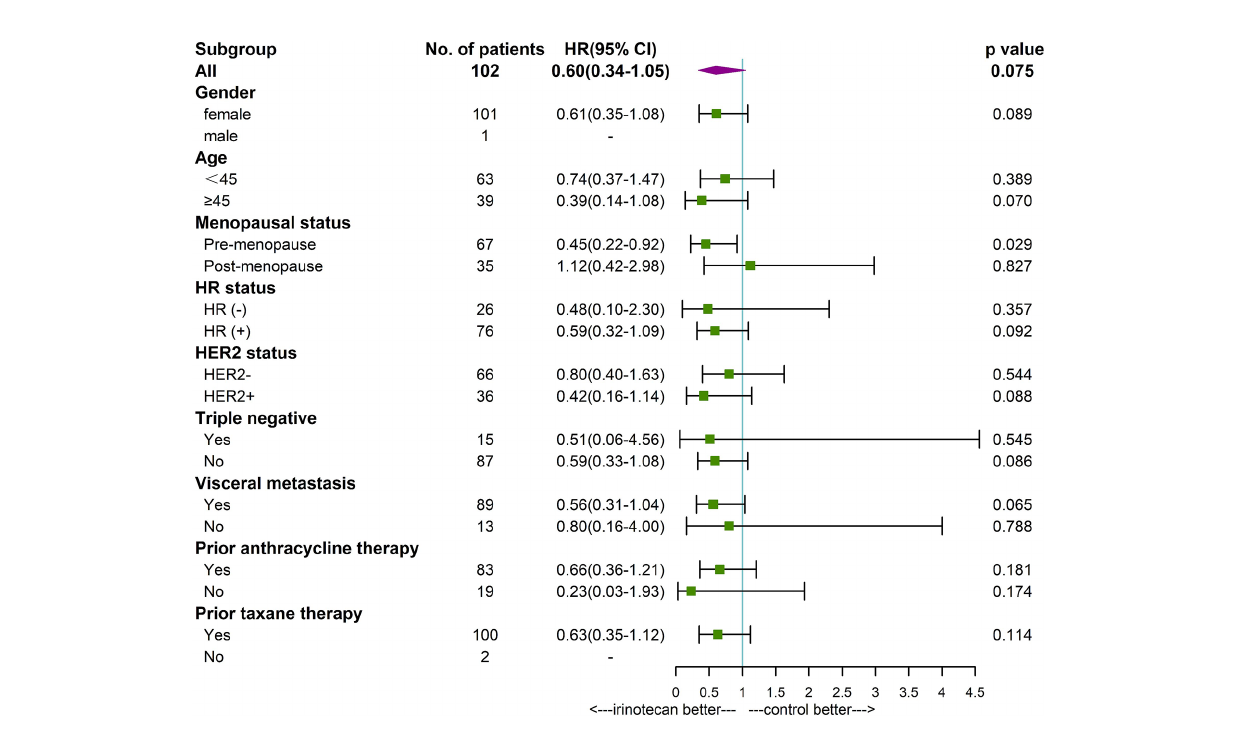
FIGURE 4 | Forest plot of OS by subgroup.